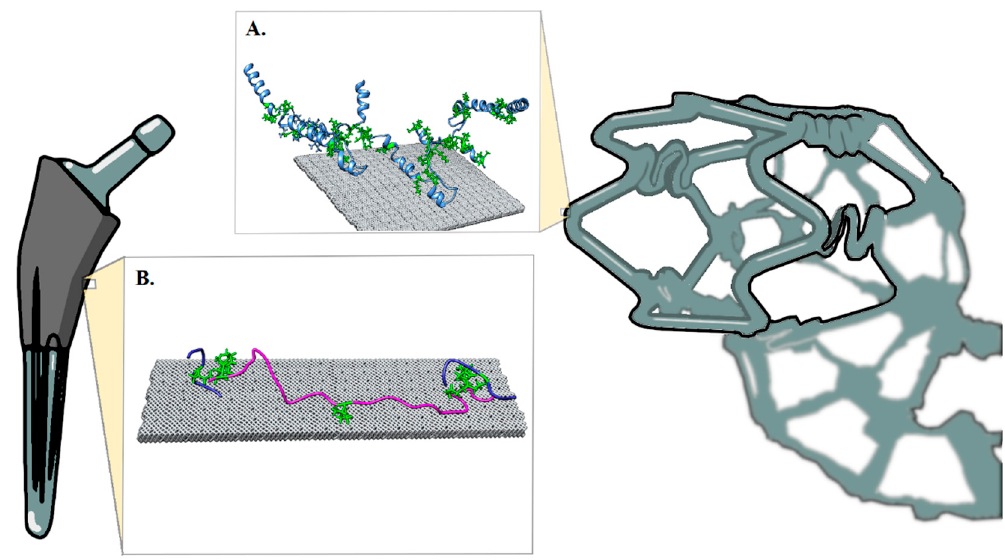
Figure 1. Methacrylated Proteins with lysine residues in green. ( A ) Methacrylated protein for cardiovascular applications (a crosslinked troponin trimer, blue, is shown attached to a gray titanium surface.). ( B ) Gelatin methacrylate (GelMA) trimer (magenta, blue).